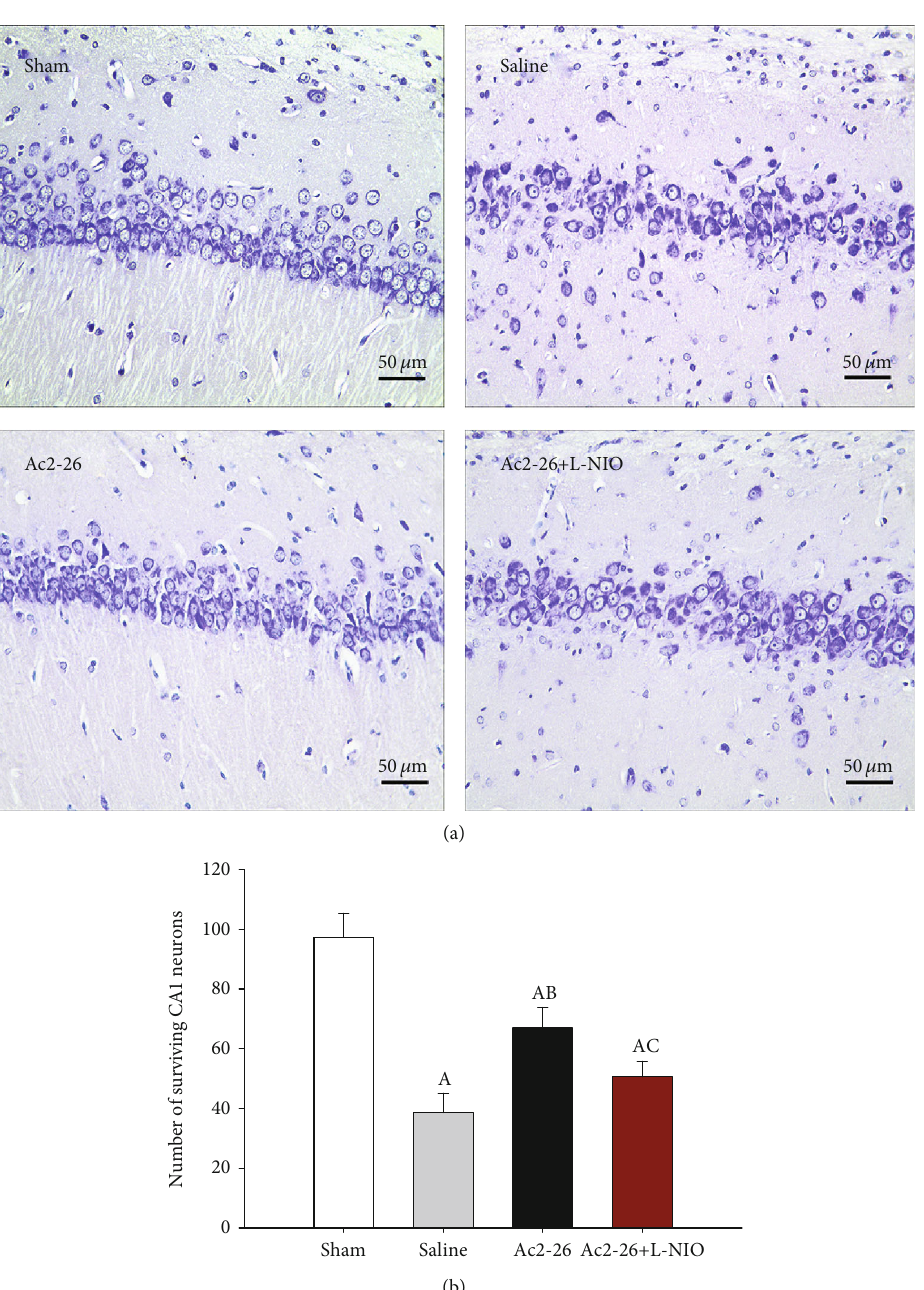
Figure 2: Number of surviving CA1 neurons after ROSC. Nissl staining was used to measure neuronal survival in the hippocampal CA1 region 72 hours after ROSC (magni fi cation 400-fold) (a) The number of surviving neurons in the CA1 region of the hippocampus. (b) Data are presented as mean ± SD . A P < 0 : 05 vs. sham group; AB P < 0 : 05 vs. saline group; AC P < 0 : 05 vs. Ac2-26 group (, sham group; , saline group; , Ac2-26 group; , Ac2-26+L-NIO